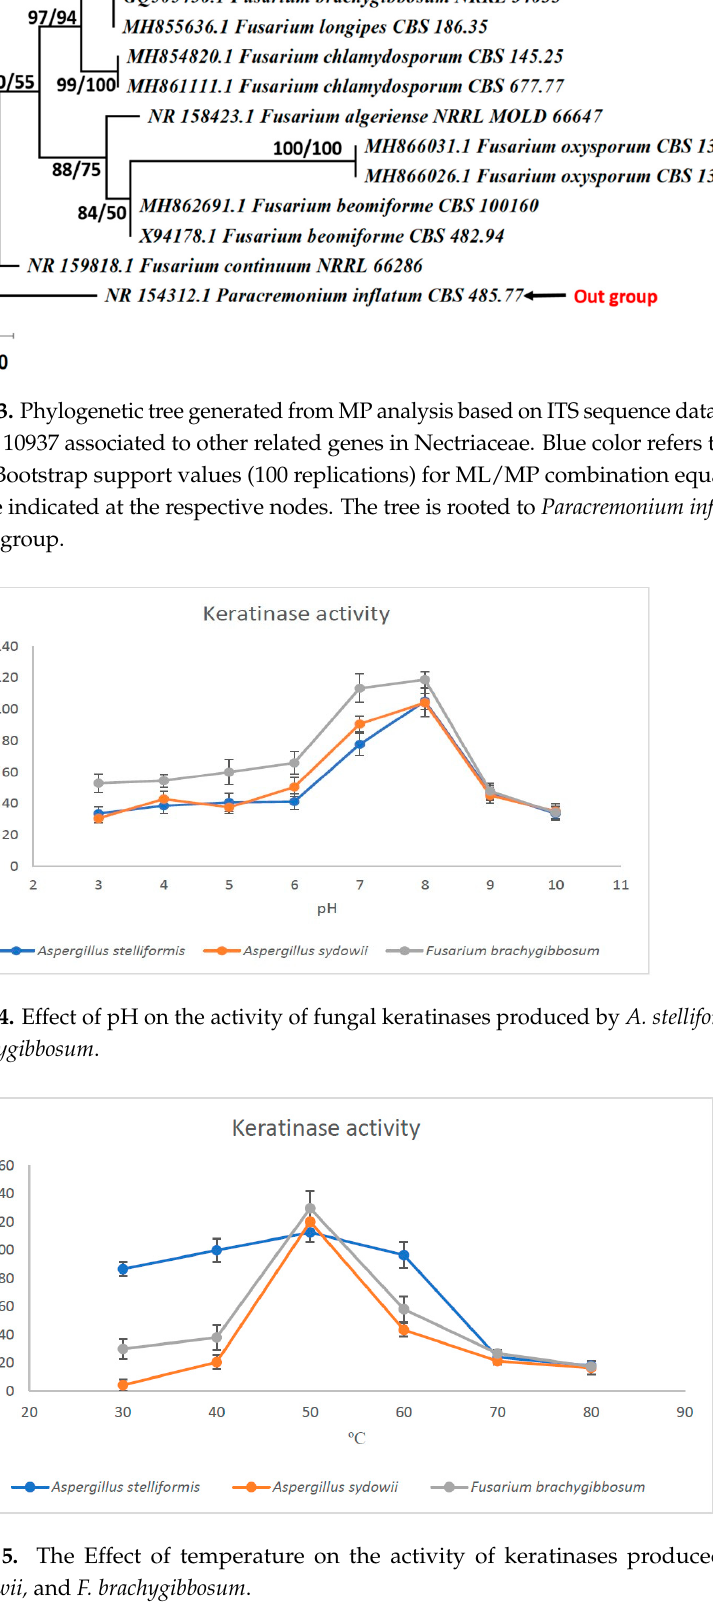
Figure 5. The Effect of temperature on the activity of keratinases produced by A. stelliformis, A. syd- owii, and F. brachygibbosum . A. sydowii, and F. brachygibbosum